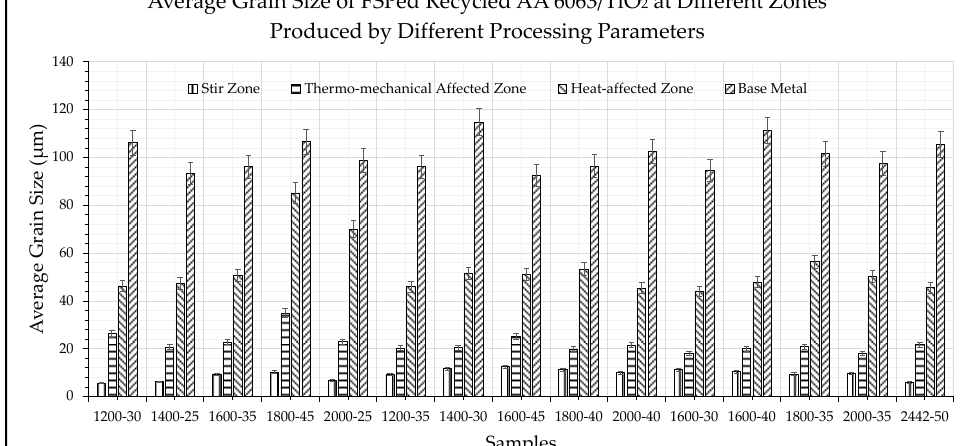
Figure 12. The average grain size of FSPed samples at different zones produced by different processing parameters.